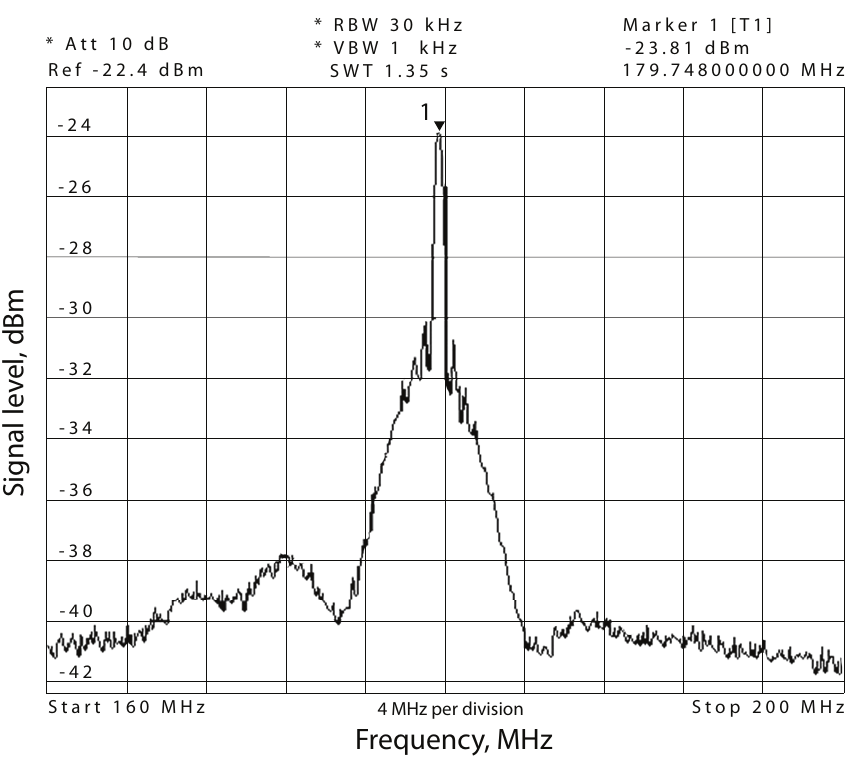
Fig. 5. The spectrum of the signal, emitted by a satellite of the navigation system GLONASS, recorded at Irbene after conversion to the intermediate frequency. The cen- tral frequency (in MHz) and the level (in dBm) of the signal emitted by the satellite is denoted by a marker